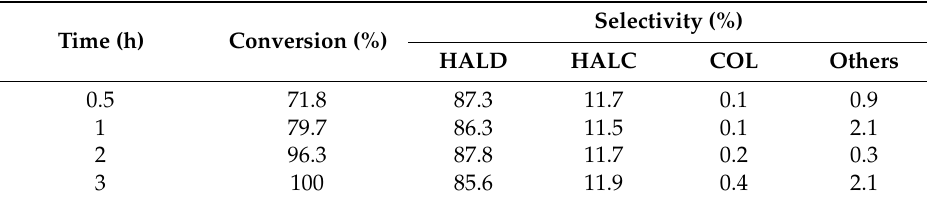
Table 6. Effect of reaction time on activity over 0.2%Pd-1.2%Ni/SBA-15 a